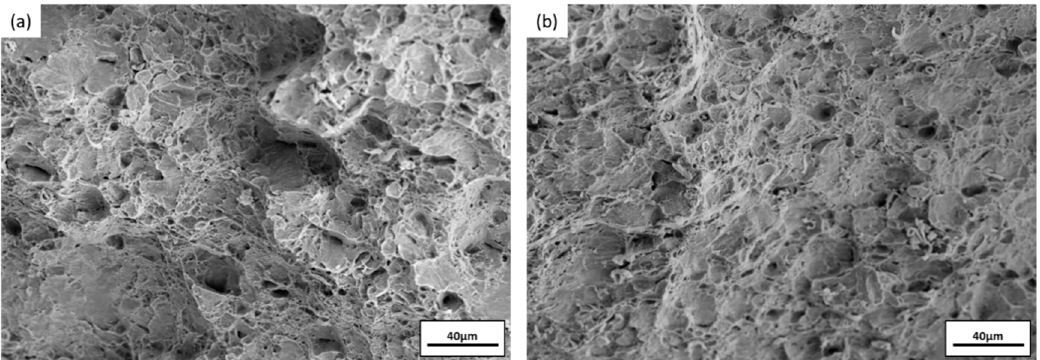
Figure 7. Fracture surface obtained in tensile test: ( a ) FH and ( b ) FRH30.